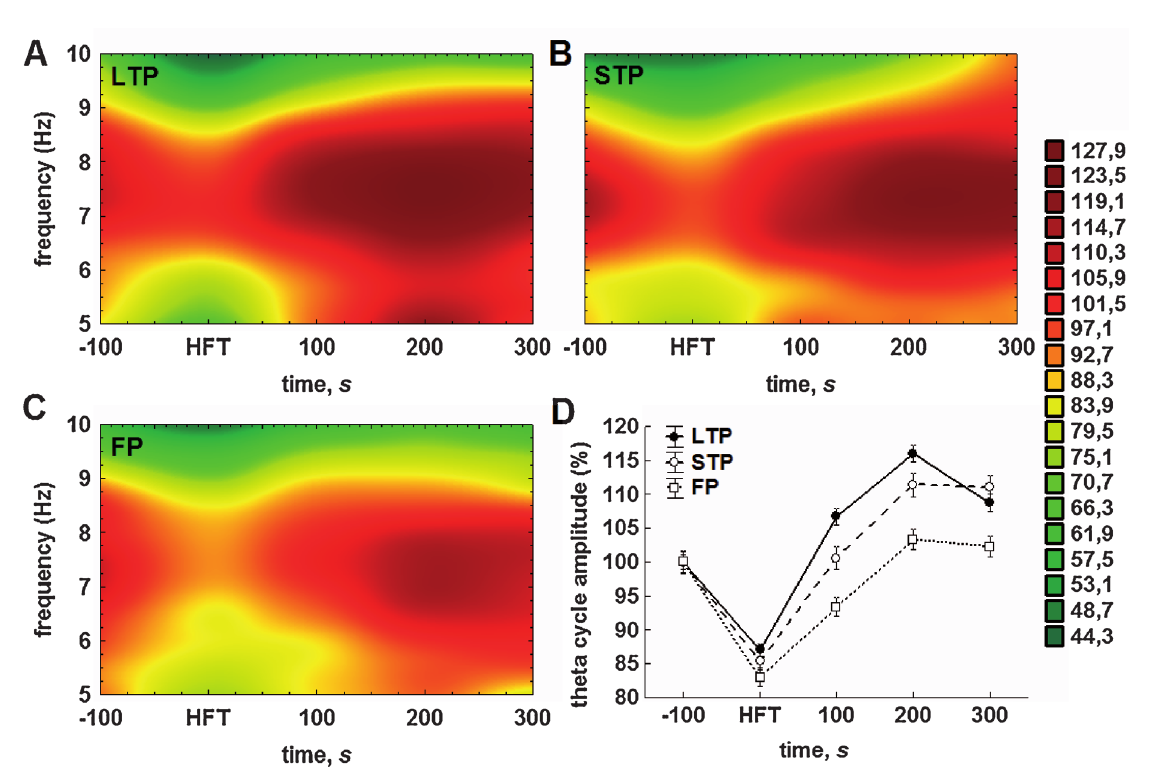
Figure 4. Either STP or LTP of synaptic strength is associated with relatively prolonged increases in the theta cycle amplitude. ( A–C ) Colour surface plots represent the mean amplitude of individual theta cycles plotted against frequency within the theta (5–10Hz) range and time to 200Hz HFT (distance weighted least squares fitting). Colour scale represents percents to the mean pre-HFT value. ( D ) Whisker plot represents mean (cid:3) SEM for LTP (filled circles), STP (open circles) and failed potentiation (open squares)